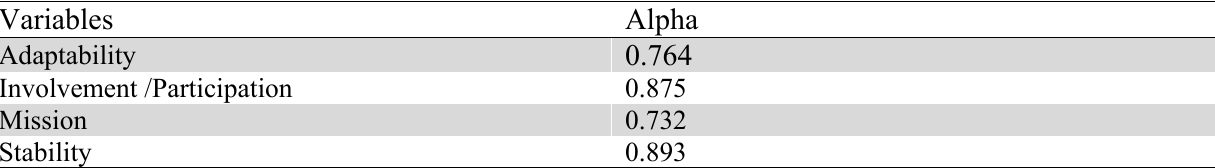
Value of Alpha Cronbach in research